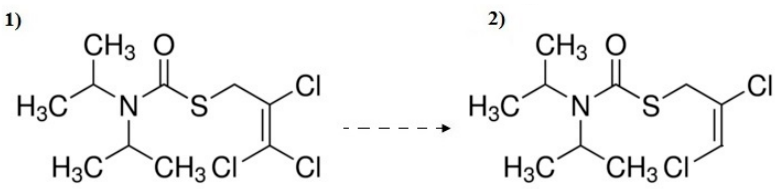
Figure 10. Identified 1 triallate by-product, where 2 is diallate.